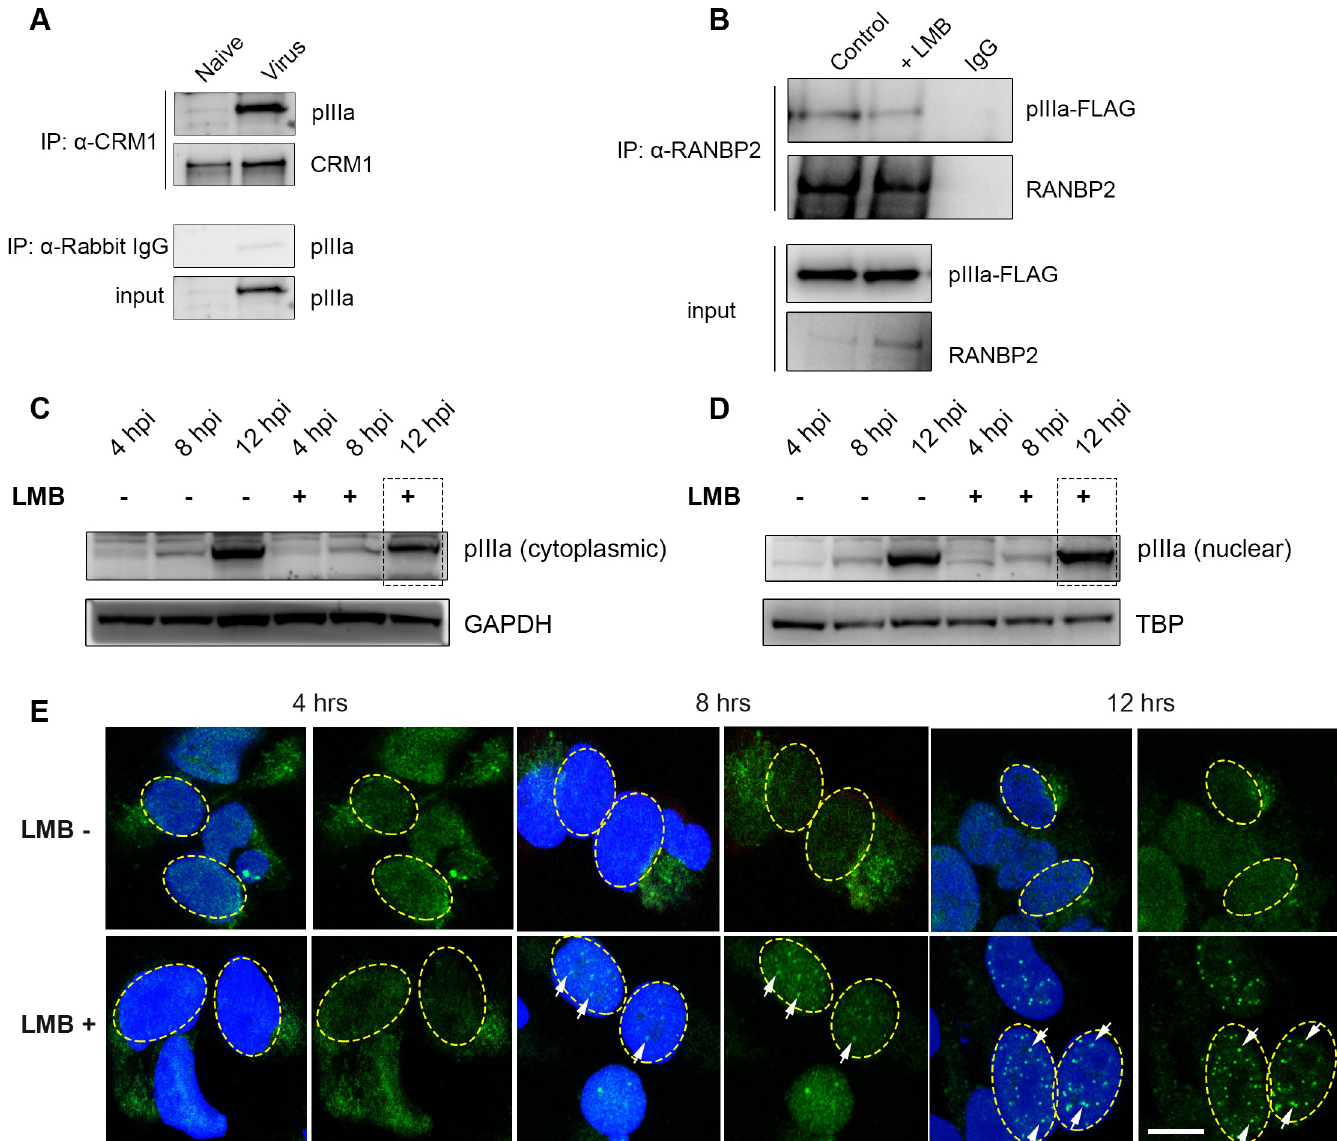
Fig 6. CRM1 nuclear export signal blocking retains human adenovirus pIIIa in the nucleus. (A) Immunoprecipitation of CRM1 in infected HEK293 cells shows pIIIa interaction with CRM1. (B) Viral pIIIa protein expression after infection of cells pretreated with 20 nmol/L leptomycin B (LMB) for 4 hrs, a specific inhibitor of CRM1 nuclear export signal, or methanol control. Cell lysates were immunoprecipitated with α -RANBP2 and immunoblot developed with α -pIIIa-FLAG antibodies. (C) Cytoplasmic and nuclear extract of extracts of HEK293 cells infected with HAdV-D37 at an MOI of 1 for 4, 8, and 12 hours post-infection (hpi), and treated with LMB or methanol control for 4 hours. GAPDH and TATA-binding proteins served as load controls for cytoplasmic and nuclear fractions, respectively. (E) Confocal images of Flp-In 293 TRex cells induced with tetracycline (20ng/mL) for 8 hrs, and treated with LMB (20 nmol/L) for 4 hrs or methanol control. DAPI nuclear (blue), pIIIa-Flag (green). Scale bar: 10 μ m. These experiments were repeated at least 3